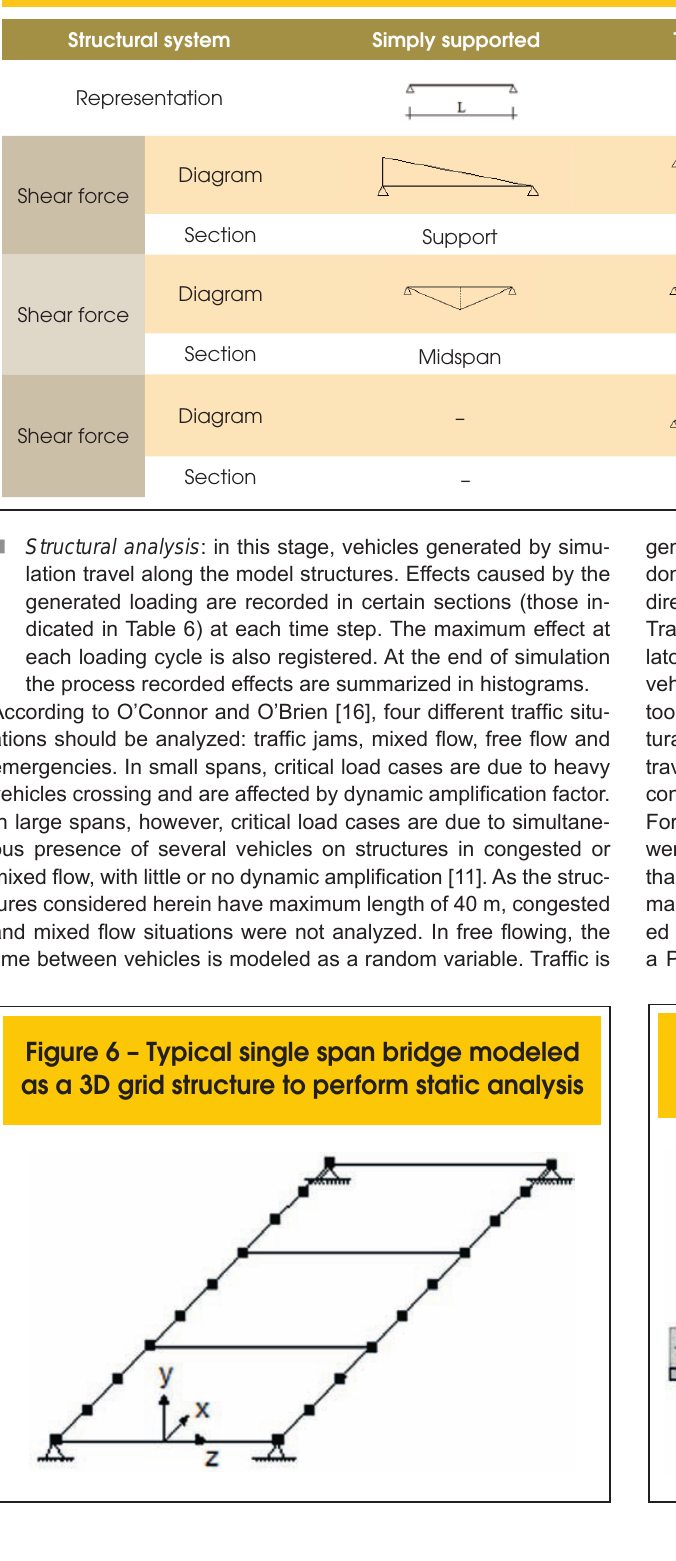
Table 6 – Structural systems, reference cross-section in girder and influence lines of critical effects considered in this paper